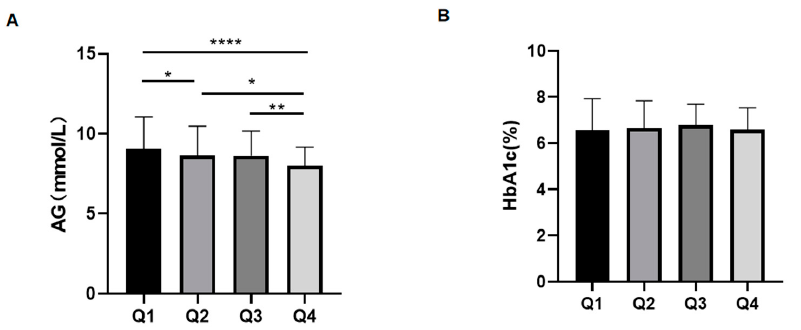
Figure 3. Comparison of average glucose (AG) and glycosylated hemoglobin (HbA1c) among the four groups of patients with type 2 diabetes mellitus (T2DM): ( A ). Comparison of AG among the four groups. ( B ). Comparison of HbA1c among the four groups. * p < 0.1 ** p < 0.01 **** p < 0.0001.